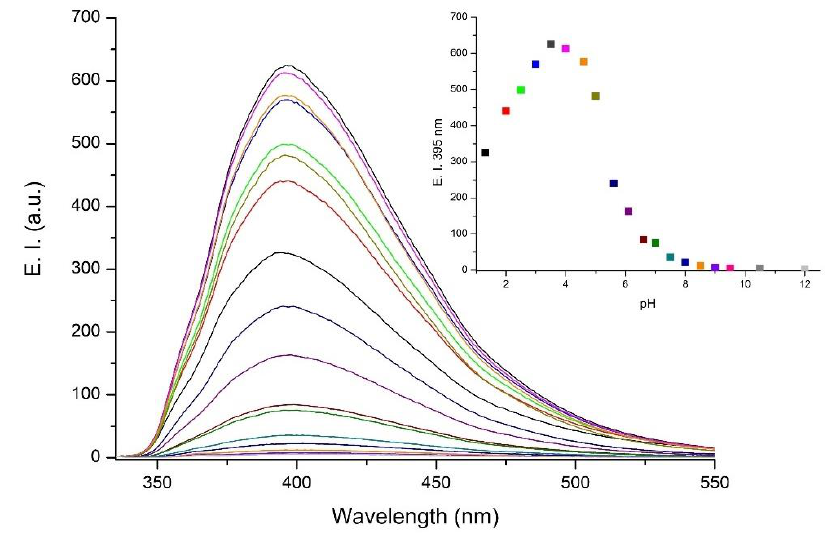
Figure 4. Fluorescence emission spectra of L registered in an ACN–water 4:1 v/v solvent mixture in the pH range of 2 − 12. Inset: trend of emission intensity at 395 nm at different pH values. [ L ] = 3.2 × 10 − 6 mol dm − 3 , λ ex = 305 nm. pH adjusted by adding HCl and NaOH aqueous solutions.